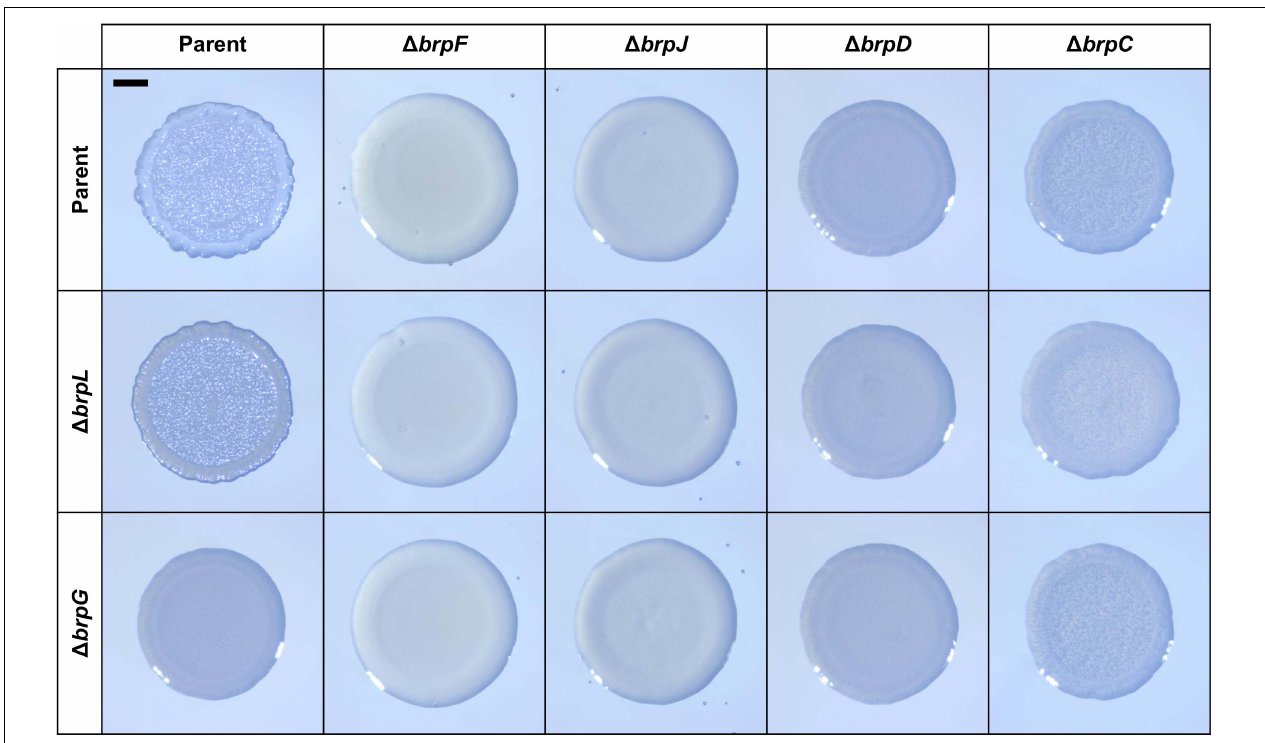
FIGURE 7 | Comparison of colony morphology resulting from the deletion of brpLG and the brp locus genes. The parent and mutant strains were spotted onto VFMG agar supplemented with 0.02% arabinose and grown for 24 h. Each colony that represented the mean rugosity from at least three independent experiments was visualized using a stereomicroscope. All images are shown at the same scale, and a 1-mm scale bar is shown on the image of the parent strain. The genes deleted in each strain are shown in top and left